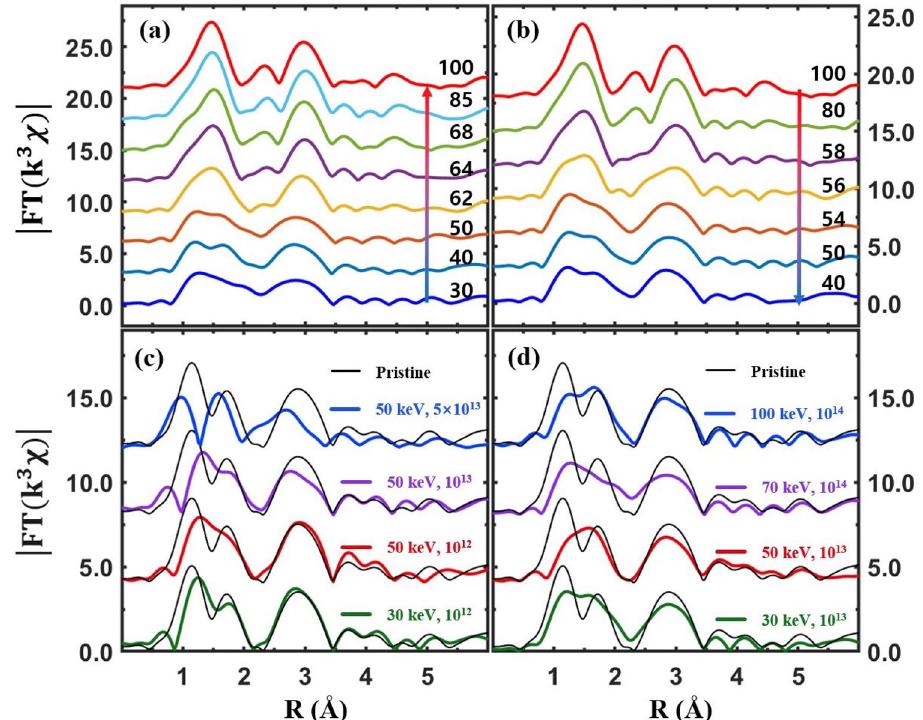
Figure 9. ( a , b ) EXAFS (|FT(k 3 χ )|) from Co-VO 2 with a Co ion energy of 70 keV and a flux of 10 14 ions/cm